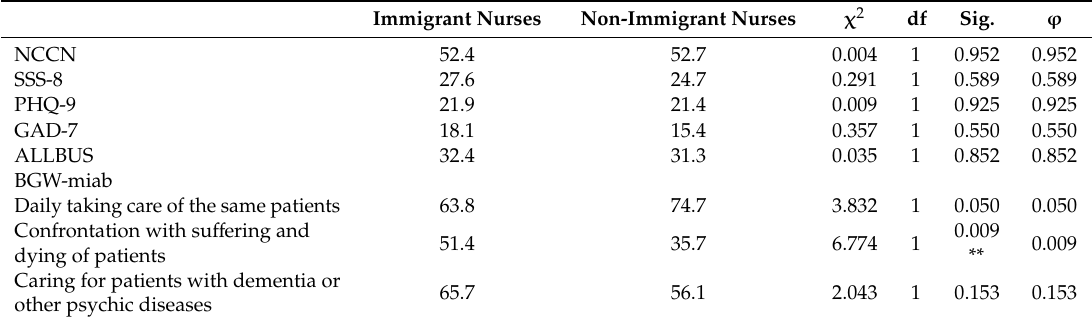
Table 3. Comparison between immigrant and non-immigrant nurses: the proportion of nurses meeting the cut-o ff